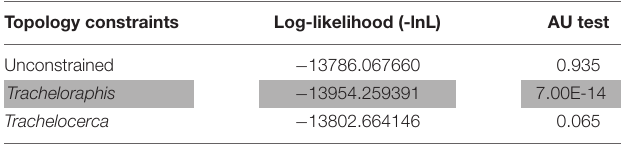
TABLE 1 | Approximately Unbiased test results based on the SSU rDNA data. Topology constraints Log-likelihood (-lnL) AU test Unconstrained − 13786.067660 0.935 Tracheloraphis − 13954.259391 7.00E-14 Trachelocerca − 13802.664146